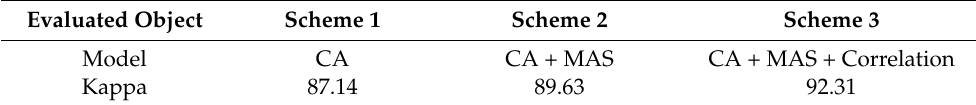
Figure 4. Differences between production-living-ecological (PLE) space evolution results from three experimental simulation schemes and remote sensing image recognition in Xuzhou, China in 2010. ( a ) is PLE recognition results of RS image in 2010; ( b – d ) are the differences between the simulation results of scheme 1, 2, 3 and the recognition results of ( a ), respectively. Table 3. Statistical precisions of PLES evolution simulation from three schemes Unit: %.